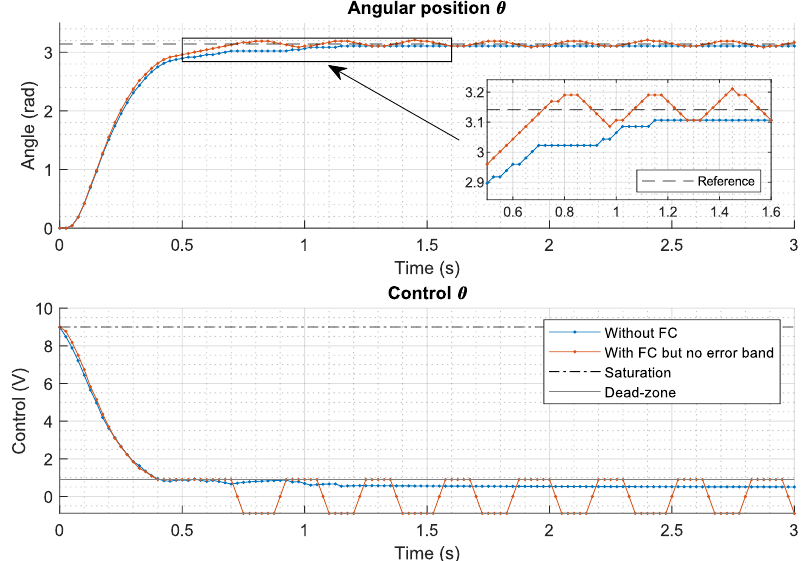
Figure 11. System response with friction compensator (20).